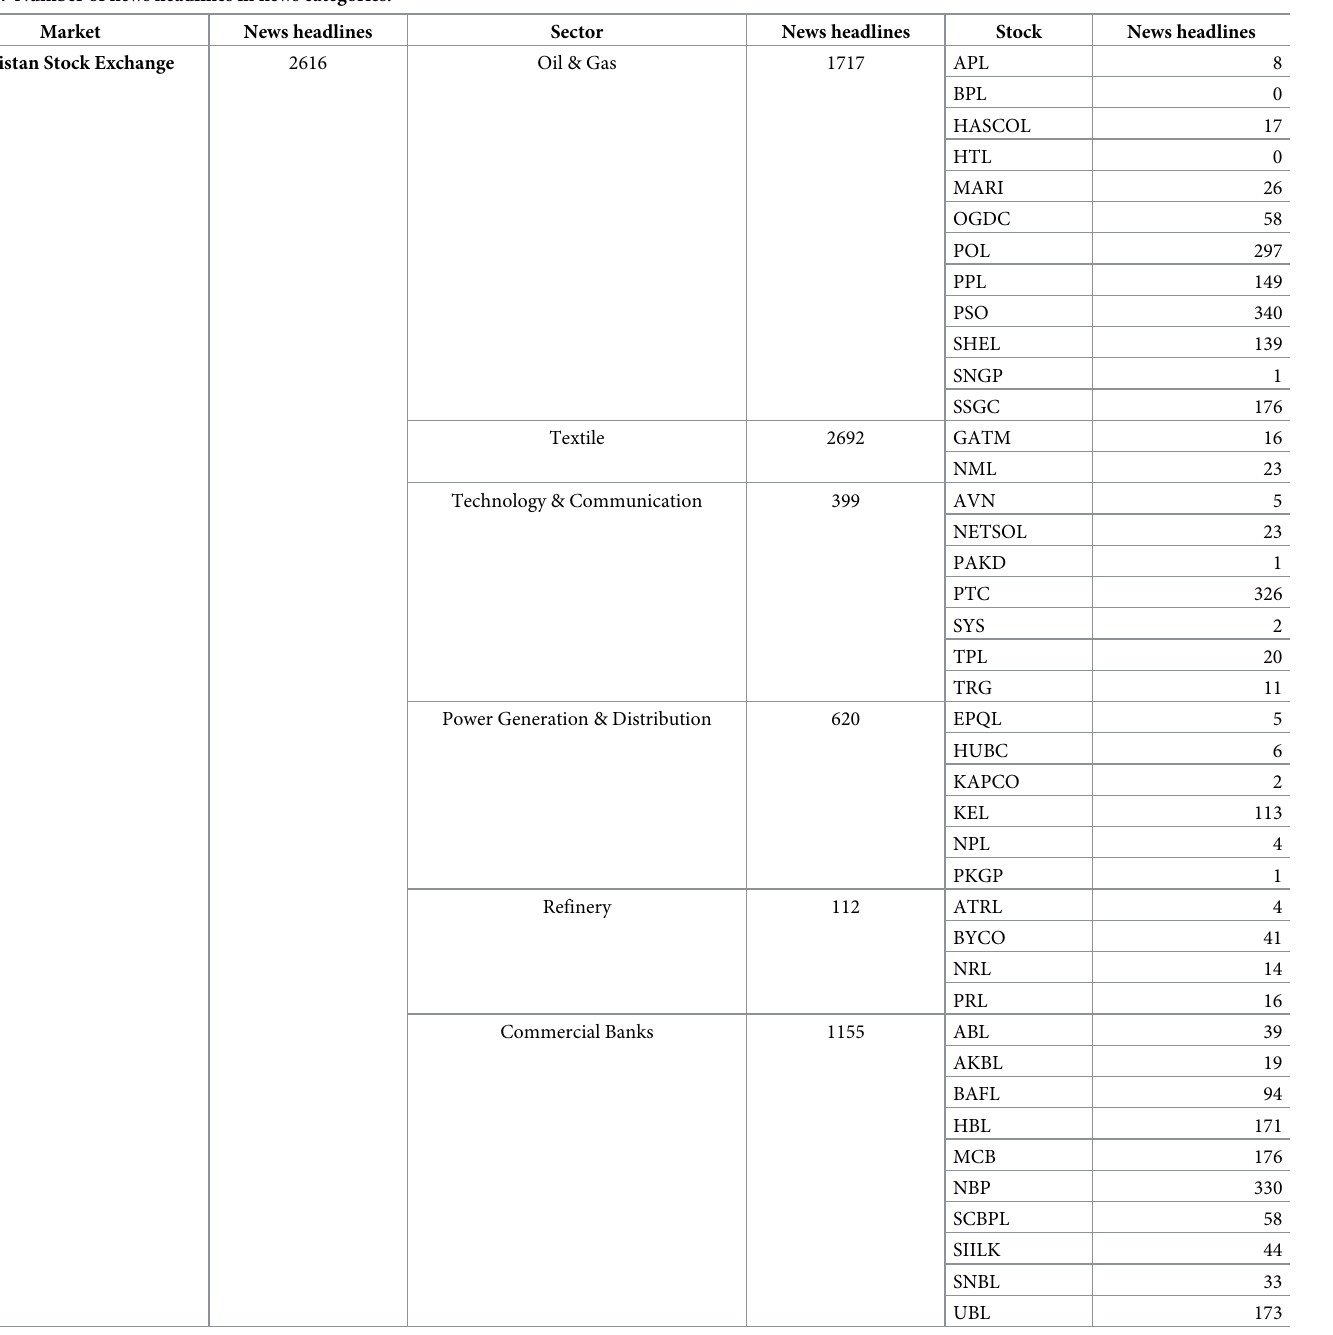
4.2.1 Technical indcators. Technical indicators are data points derived from historic stock prices and represent future price trends. They are significantly used in literature along with other textual and numerical input data [8, 13, 25]. We have used ten technical indicators suggested by Li, et al. [8]. The adopted indicators are shown in Table 3.